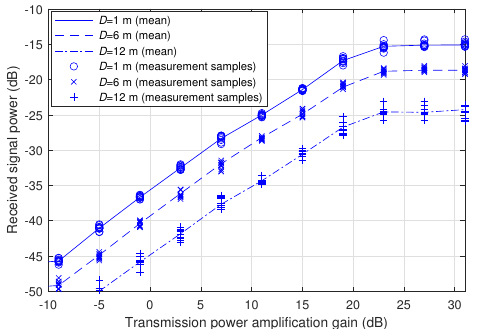
Figure 11. Received signal power versus the transmission power amplification gain of the SDR device (USRP-2901) in an outdoor open space.